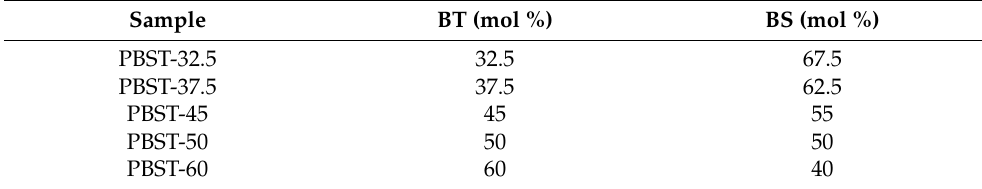
Table 1. The sample names and specific BT contents of PBST